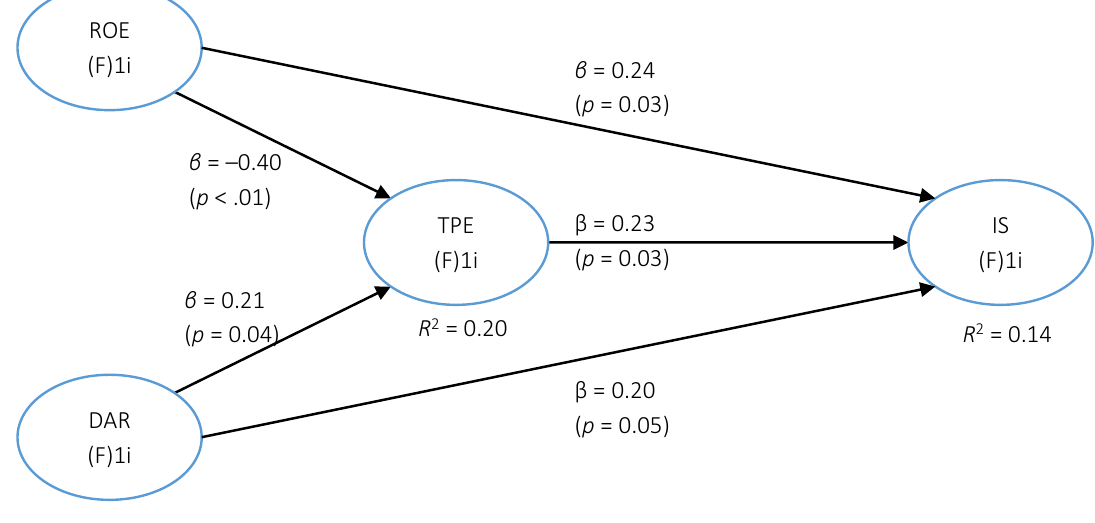
Figure 1. Results of PLS